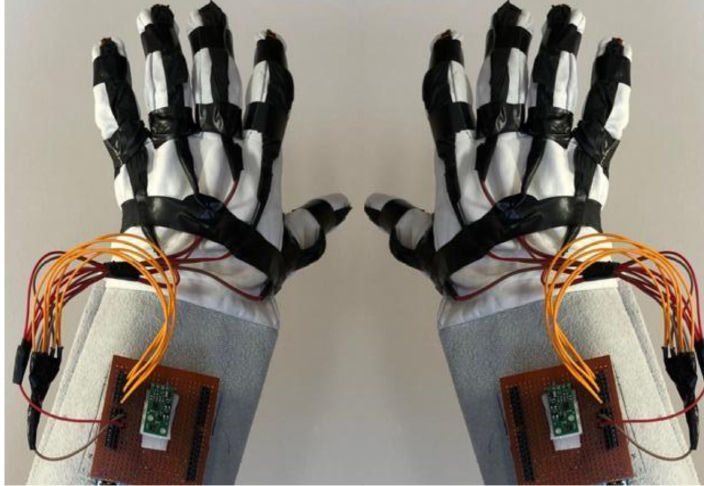
Figure 4. A pair of smart glove designs built with Flex and IMU sensors and an STM32 card. Flex sensors used in wearable smart glove design are important for detecting the bending movements of the fingers. Basically, the resistance values change depending on bending and twisting, which works with the logic of resistance. This sensor, also known as a bending sensor, has a resistance value of ~10 K Ω when in a flat state. During bending, the resistance will increase up to ~20 K Ω . These values may vary depending on the resistance used. The size and technical features of the 4.4-inch-long flex sensors (Adafruit brand) used in the system are shown in Table